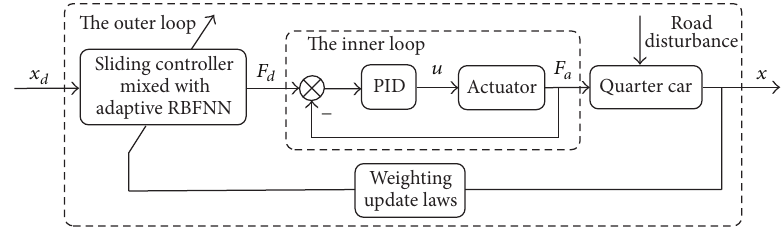
Figure 3: The system control block